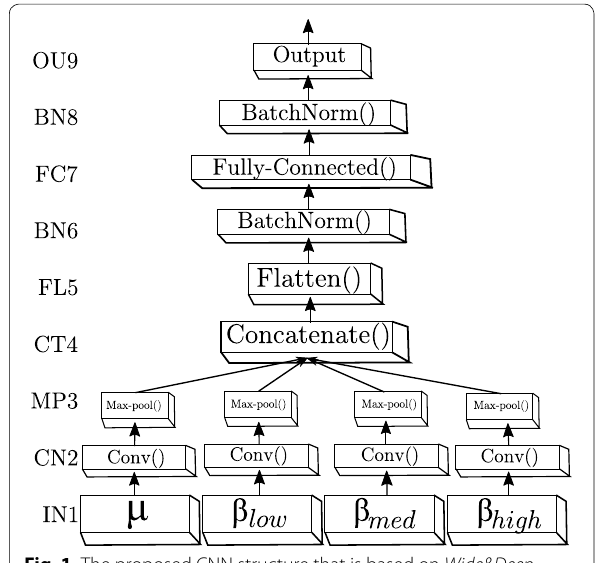
Fig. 1 The proposed CNN structure that is based on Wide&Deep neural network handling multiple inputs. The first layer (IN1) is the input, the second (CN2) and third layers (MP3) are hidden and accomplish the feature mapping generation, while the next block (ranging from the output of layer CT4 to the OU9 layer) comprises the classification